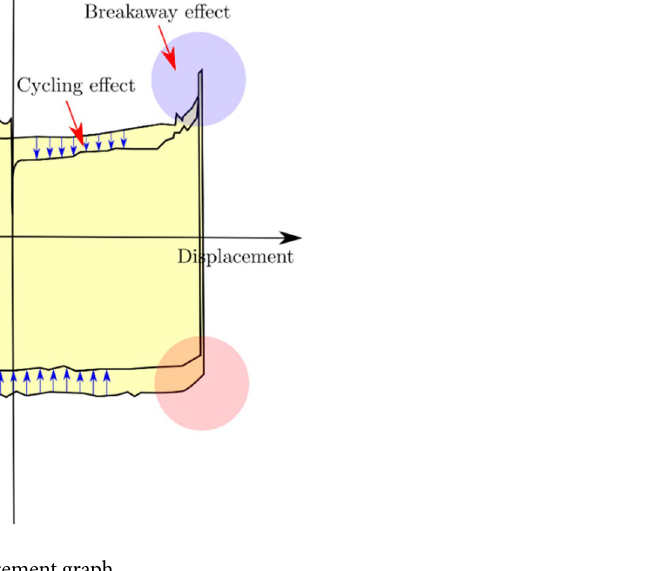
Figure 9. Typical load–displacement